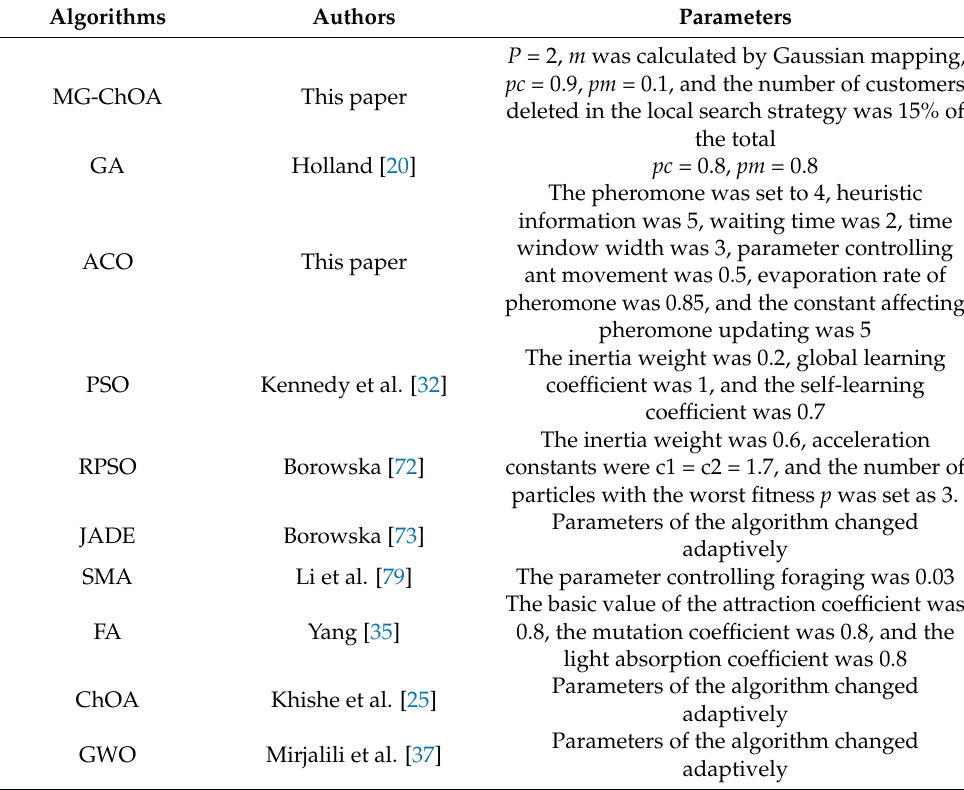
Table 2. The control parameter settings of each